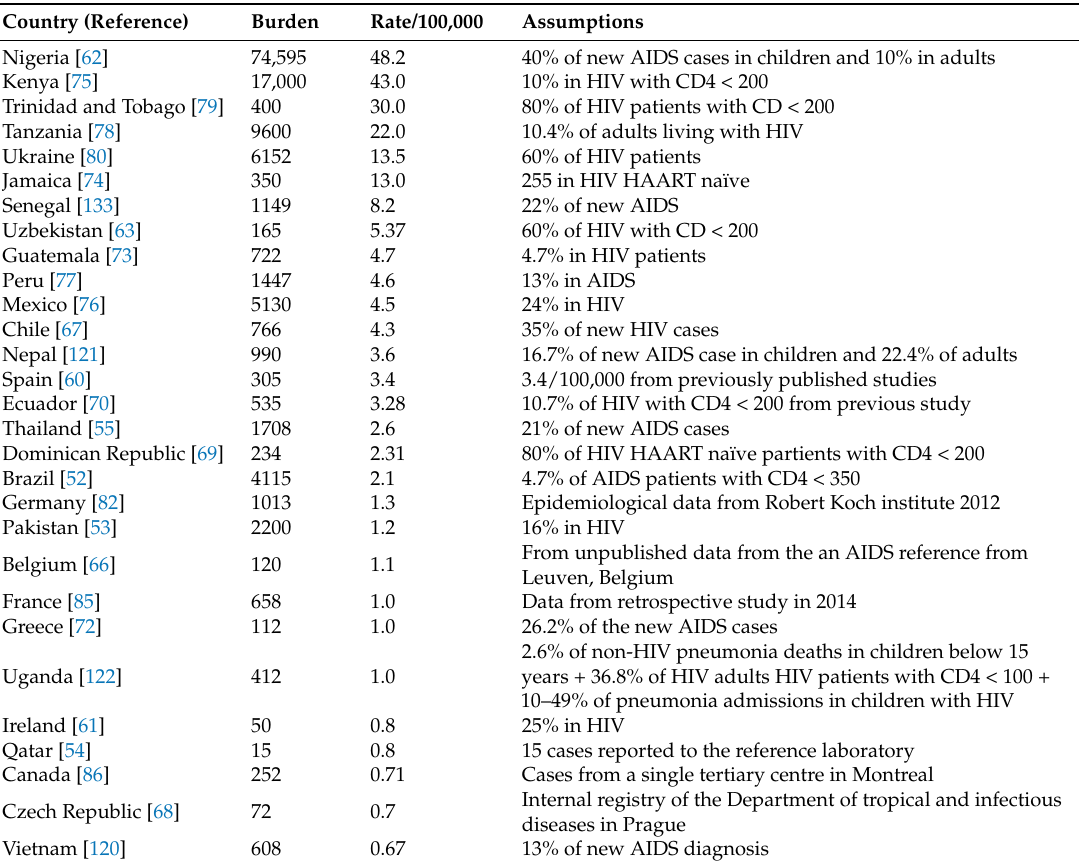
Table 4. Estimated burden of Pneumocystitis jirovecii